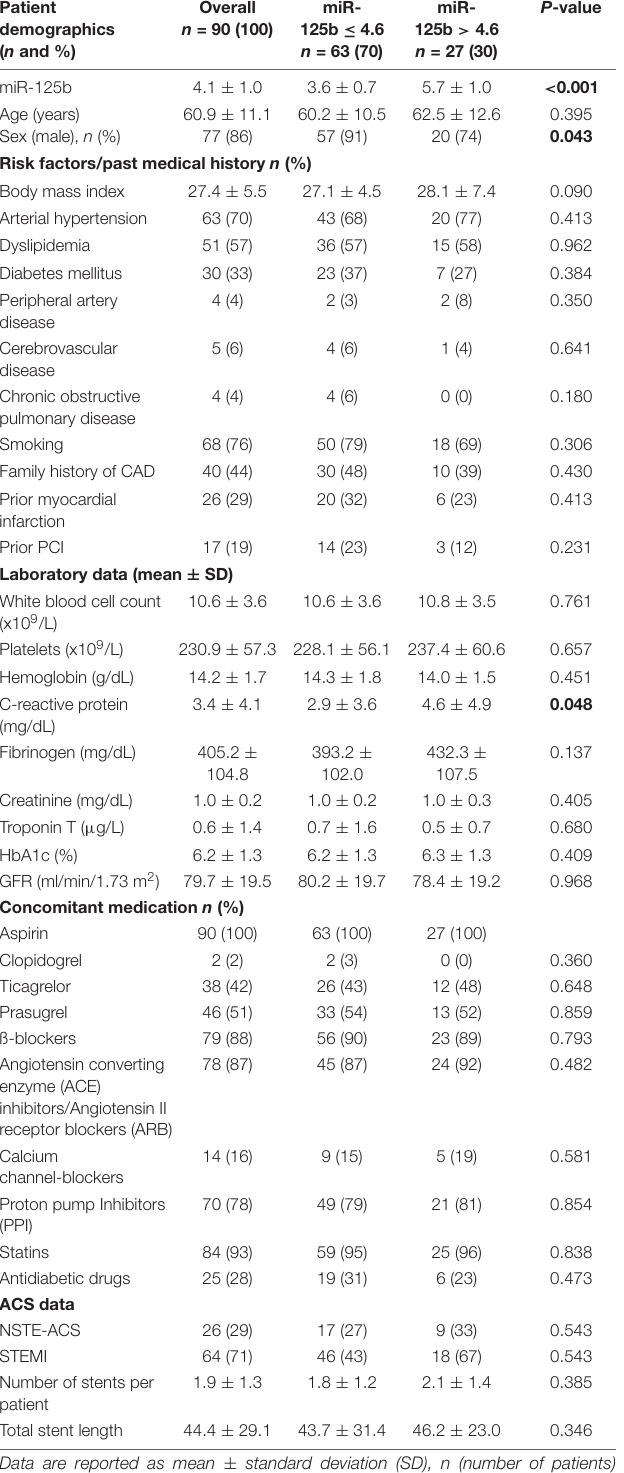
TABLE 1 | Patient demographics.